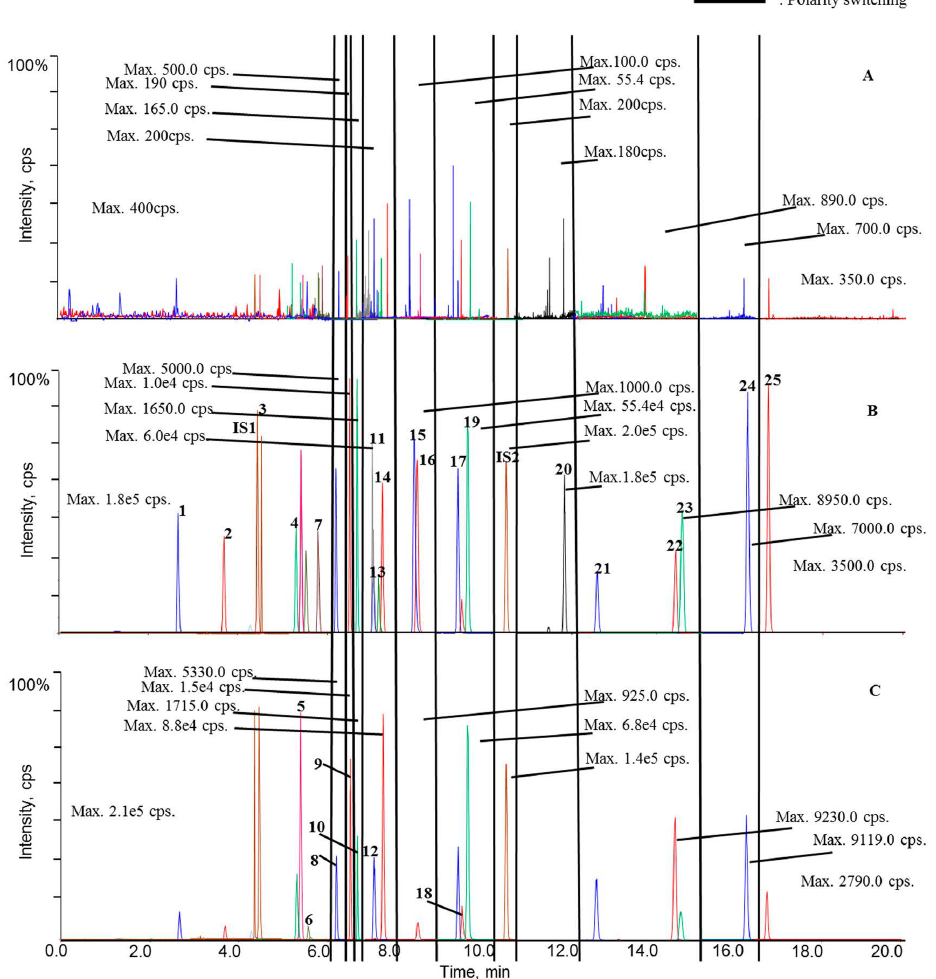
Figure 2. Typical chromatograms of blank plasma ( A ); blank plasma sample spiked with twenty-five analytes and internal standards ( B ); and plasma sample 1.0 h from a selected sham rat after oral administration of QSKL ( C ). As described above, polarity switching (marked with black lines) occurs for eleven times. Each segment is appropriately magnified to assure every signal visible, and the intensities of all the base peaks (highest signals) are shown. ( 1 ) harpagide; ( 2 ) morroniside; ( 3 ) sweroside; ( 4 ) liquiritin apioside; ( 5 ) liquiritin; ( 6 ) luteoloside; ( 7 ) isoacteoside; ( 8 ) benzoylmesaconine; ( 9 ) isoliquiritin; ( 10 ) benzoylhypaconine; ( 11 ) harpagoside; ( 12 ) liquiritigenin; ( 13 ) luteolin; ( 14 ) calycosin; ( 15 ) aconitine; ( 16 ) hypaconitine; ( 17 ) isoliquiritigenin; ( 18 ) glycyrrhizic acid; ( 19 ) formononetin; ( 20 ) licochalcone A; ( 21 ) dihydrotanshinone I; ( 22 ) cryptotanshinone; ( 23 ) tanshinone I; ( 24 ) glycyrrhetic acid; ( 25 ) tanshinone II A .